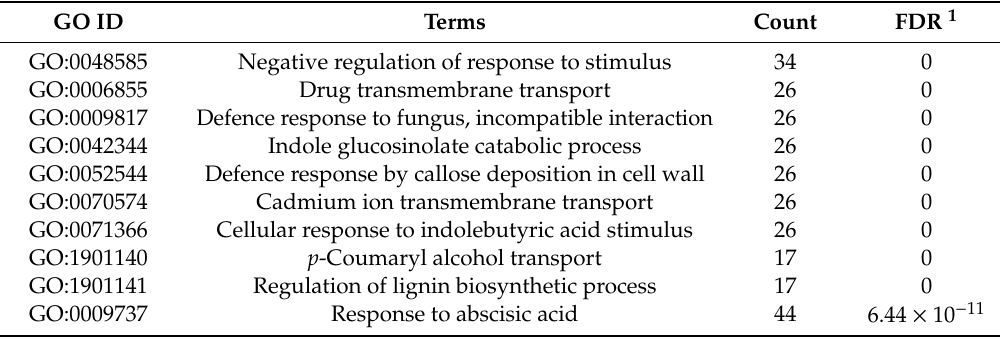
Table 2. Gene ontology (GO) enrichment of acibenzolar- S -methyl-specific patterns.